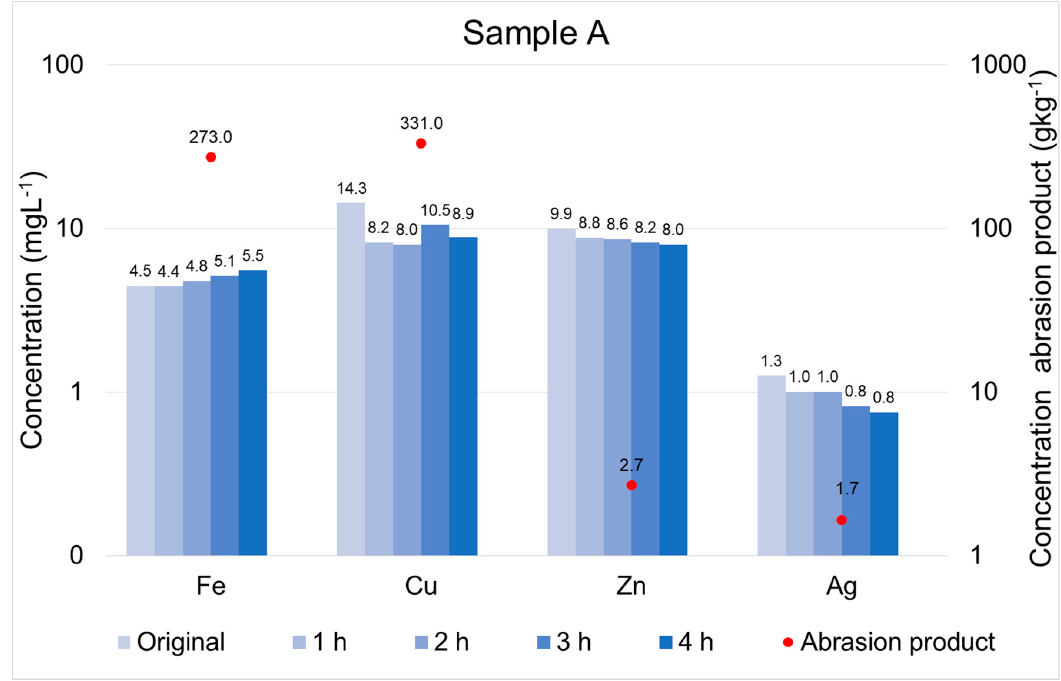
Figure 2. Evolution of the dissolved concentrations (blue bars) and concentrations in the resulting abrasion product (red dots) of Fe, Cu, Zn, and Ag during the Ferrodecont treatment of sample A. XRD analyses (Figure 3) reveal that Cu is present as metallic Cu, delafossite (CuFeO 2 ), cuprite (Cu 2 O), paratacamite (Cu 2 (OH) 3 Cl) and calcium copper oxide (CaCuO 2 ), whereas Fe is bound to goethite ( α -FeOOH), lepidocrocite ( γ -FeOOH) and also delafossite. With respect to recycling, the